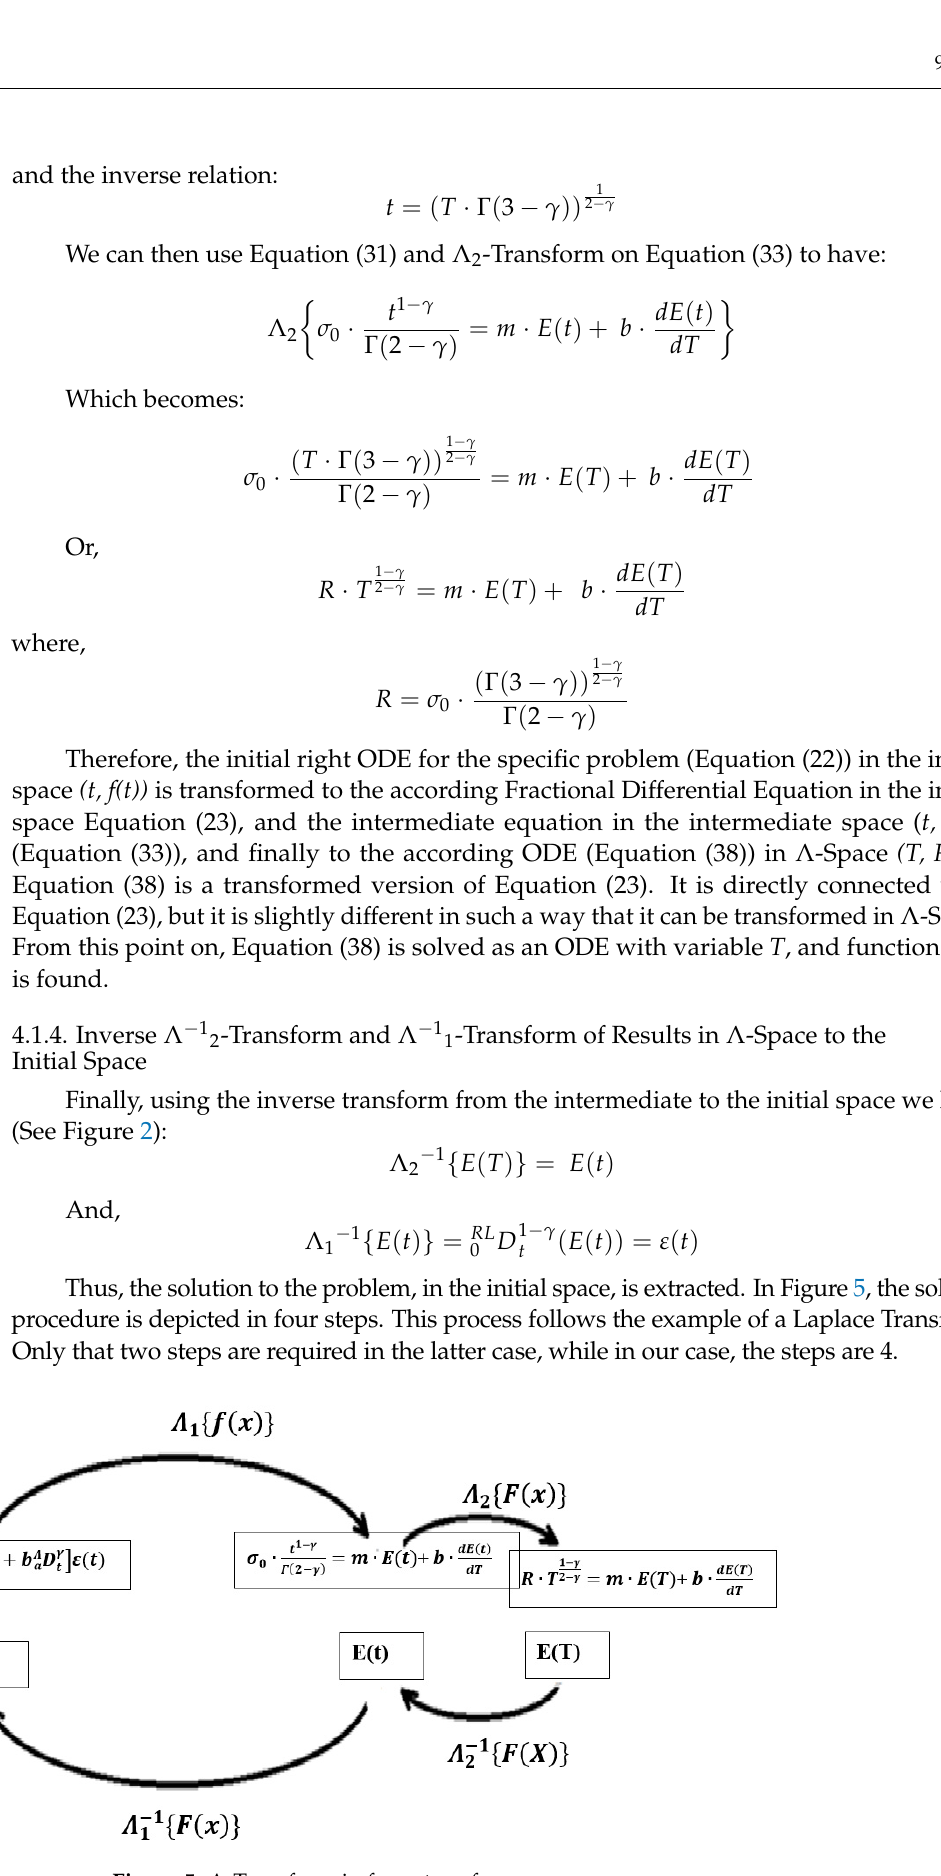
Figure 5. Λ -Transform in four steps for